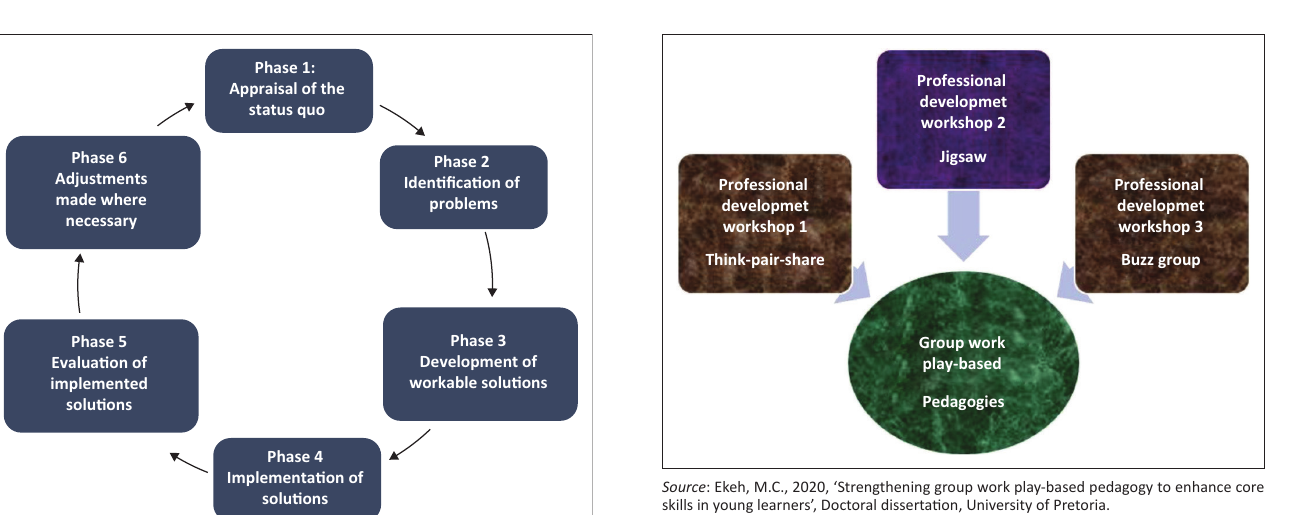
FIGURE 2: Professional development workshops on group-work play-based